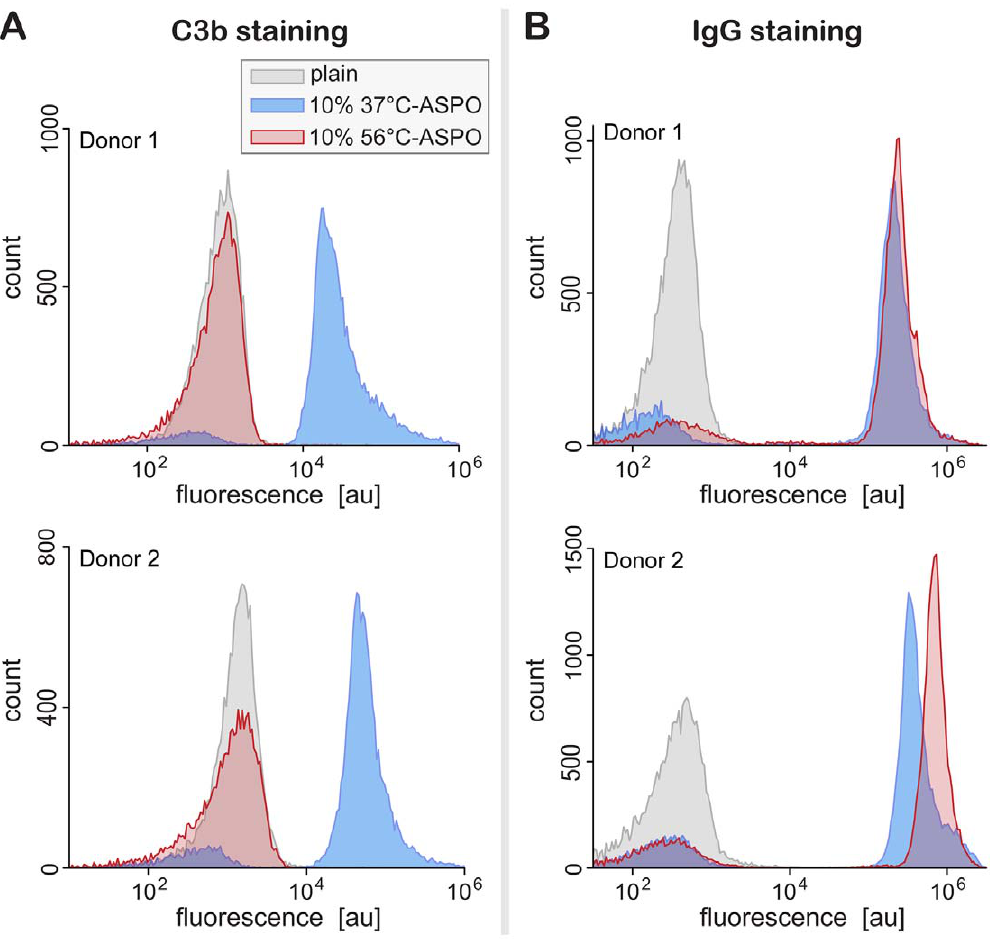
Figure 1. Example histograms of the fluorescence intensity of stained zymosan particles measured by flow cytometry. ( A ) Results of staining with FITC-conjugated anti-C3b. ( B ) Results of staining with Alexa-Fluor H -488-conjugated anti-IgG. In all cases, the particles had been incubated in three different buffers, i.e., serum-free HBSS (‘‘plain’’), HBSS with 10% untreated autologous serum (37 u C-ASPO), and HBSS with 10% autologous serum that had been heat-treated at 56 u C (56 u C-ASPO). The legend included in (A) applies to all panels. Figs. 3B and 3C. We tracked the tip of the protrusive pseudopod in recorded video images using custom-written software. Positional traces such as shown in Fig. 3C substantiated that the pseudopod did not gradually turn to follow the target particle to its new position. Instead, relocation of the zymosan particle led to the retraction of the previous pseudopod and the formation of a new one from an initially unperturbed cell-surface region facing the new particle position. The positional traces also allowed us to characterize the pseudopod’s time-dependent behavior, including its maximum extension as well as the speeds of protrusion and retraction.